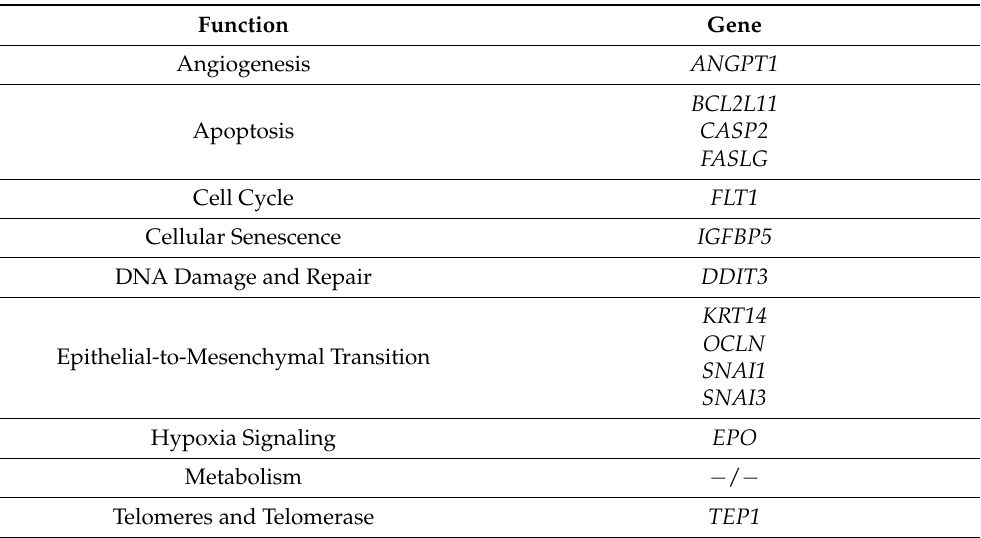
Table 2. Overview of the genes and their corresponding pathways that showed the strongest expres- sion